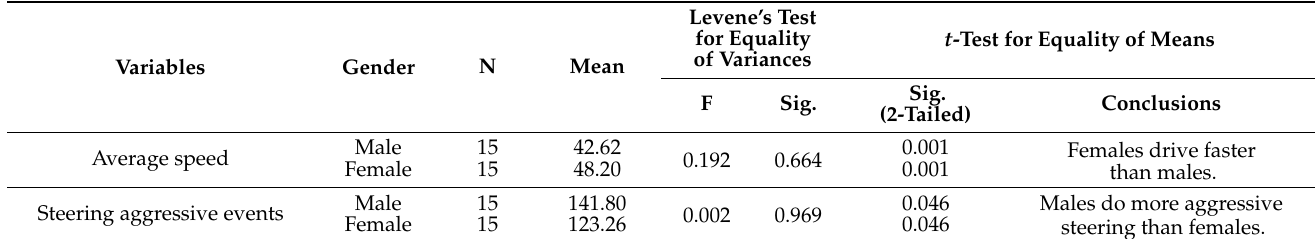
Table 4. Statistical differences in gender group.